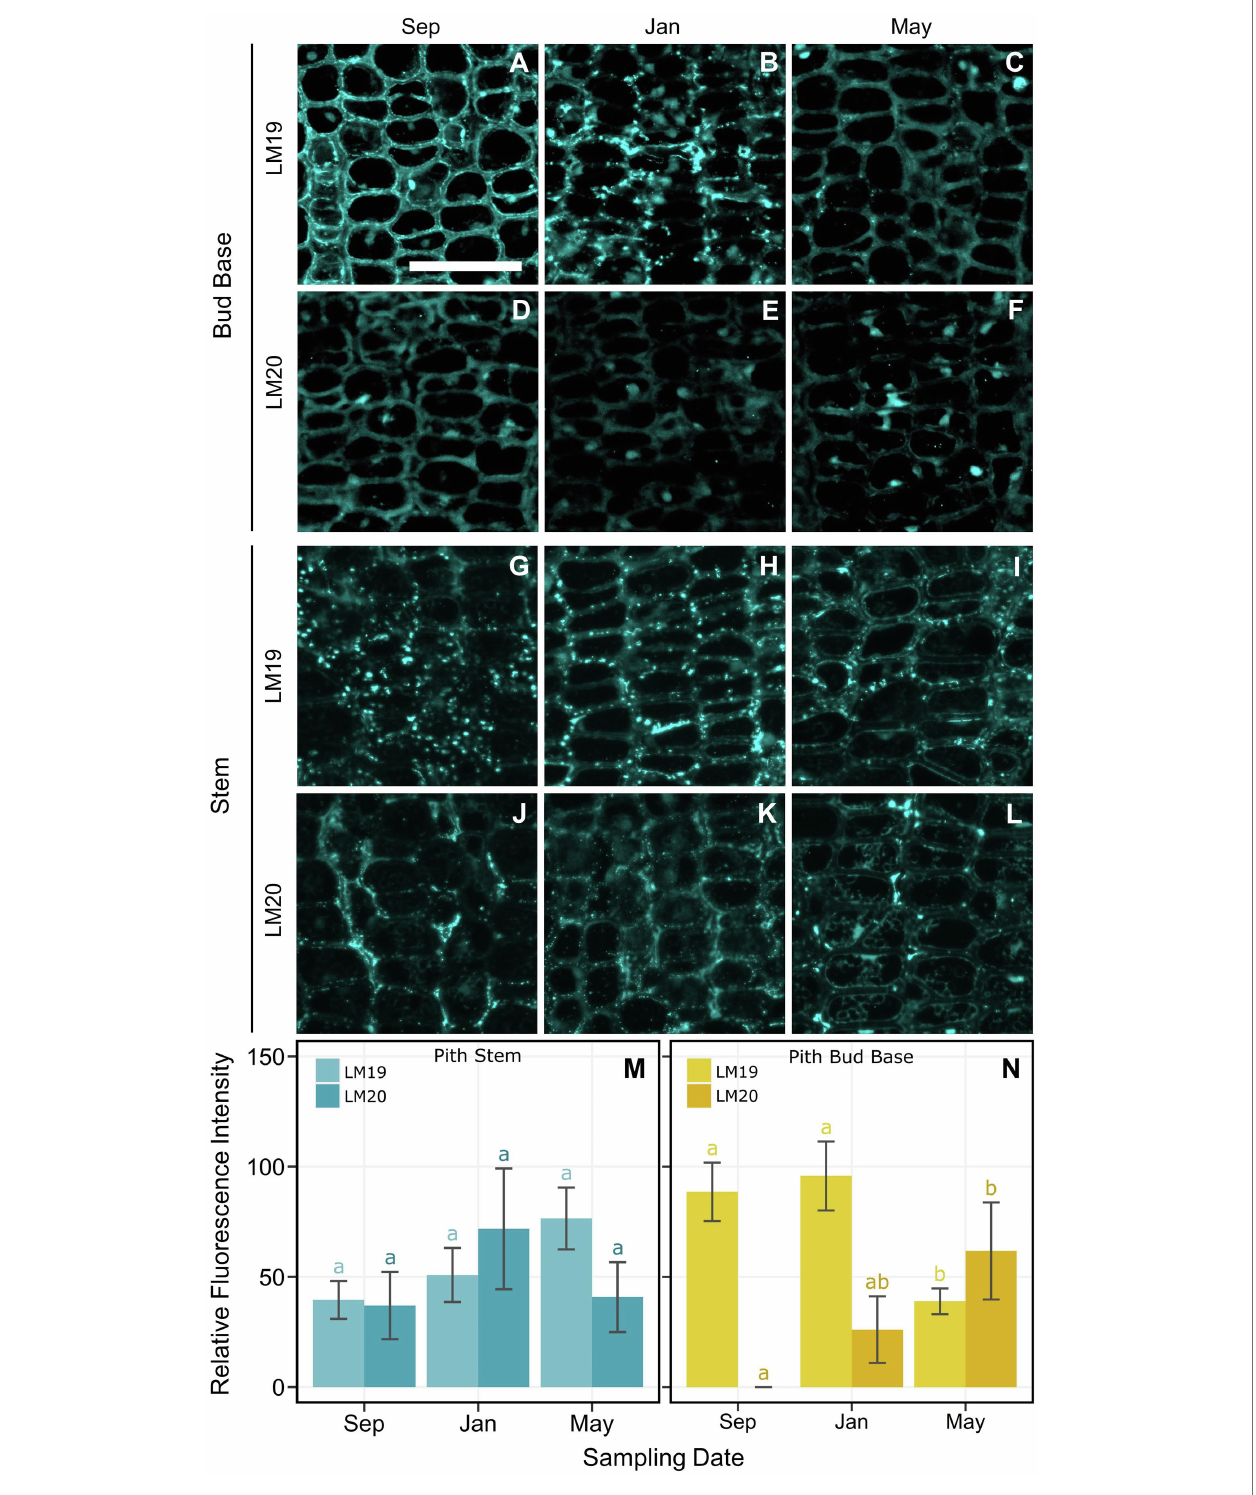
FIGURE 7 | Indirect immunolocalization with antibodies (A–C , G–I) LM19 (de-methyl-esterified form) and (D–F , J–L) LM20 (methyl-esterified form), targeting homogalacturonan in pith cells of Vaccinium macrocarpon . (A–L) Columns represent sampling dates, rows represent sub-grouped evaluated zone, bud base or stem by antibody LM19 and LM20. (M) Bar plot for the average relative fluorescence intensity for pith cells in the stem. (N) Bar plot for the average relative fluorescence intensity for pith cells at the bud base. Lower case letters represent significant difference among the means of the same antibody and tissue in each plot. Vertical lines represent the SE of the mean. Scale bar = 50 μ